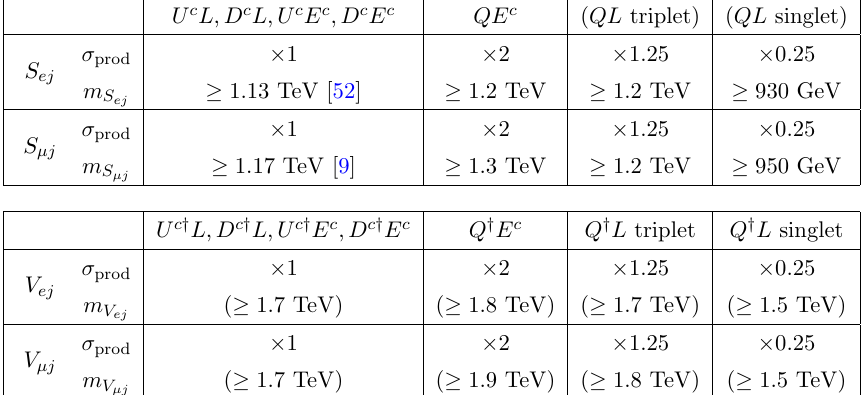
ej and S (cid:22)j . The